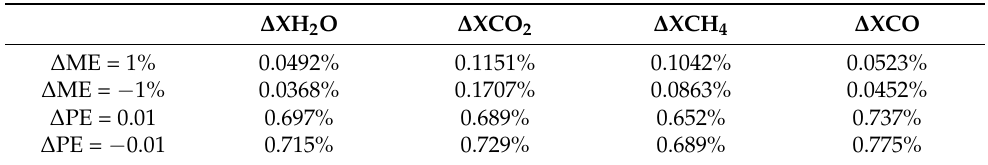
Table 2. Difference of XH 2 O, XCO 2 , XCH 4, and XCO with ± 1% in modulation efficiency and ± 0.01 in phase